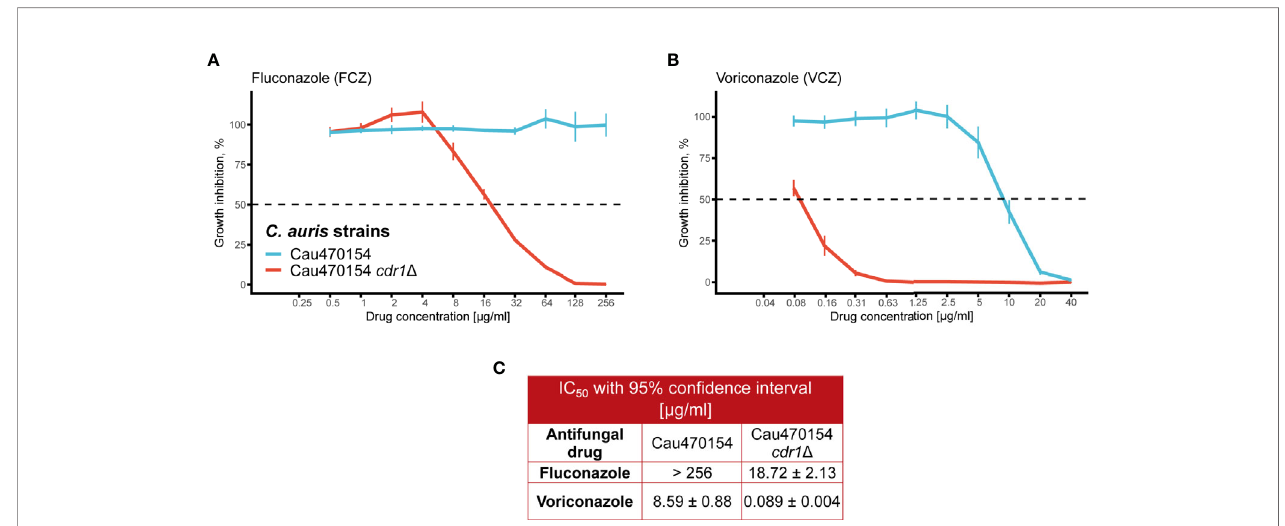
FIGURE 4 | Deletion of CDR1 abolishes azole resistance in C. auris . (A) The C. albicans CDR1 homologue was deleted in 470154 and fl uconazole susceptibility was quanti fi ed using a liquid growth inhibition assay. Cells were incubated with the indicated antifungal concentrations at 30°C for 24 hours prior to OD 600 measurement. Fluconazole resistance is abolished upon deletion of CDR1 . (B) Lack of CDR1 renders 470154 susceptible to voriconazole. Cells were treated as described in (A) . (C) 50% inhibitory concentrations (IC 50 ) for antifungals tested in A-B are listed. (A, B) Data are shown as mean +/- SD from 4 biological